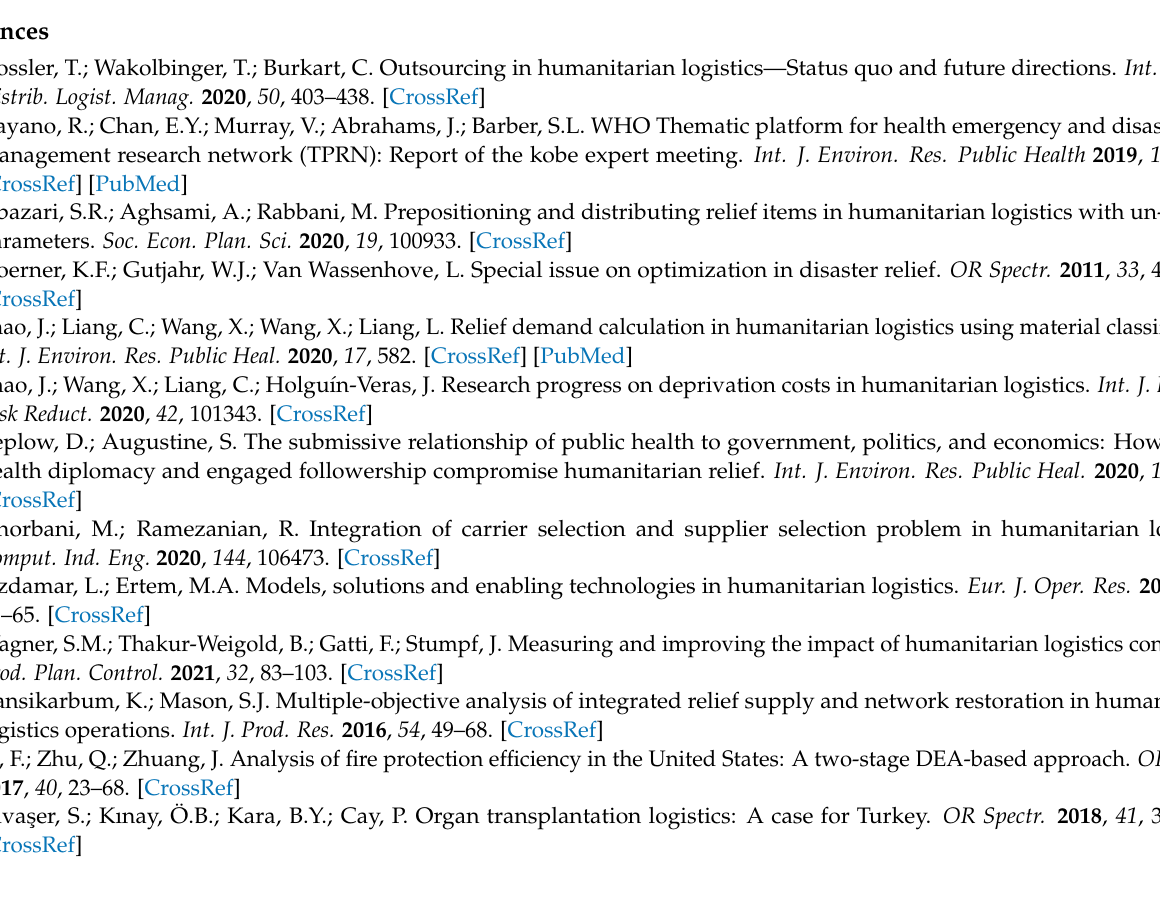
Table S8: Results output-oriented DEA calculations NGO model; Table S9: Results for DEA bootstrap calculations with 1,000 iterations; Table S10. Results for DEA window analysis, window width w = 2 and w = 3, integrating